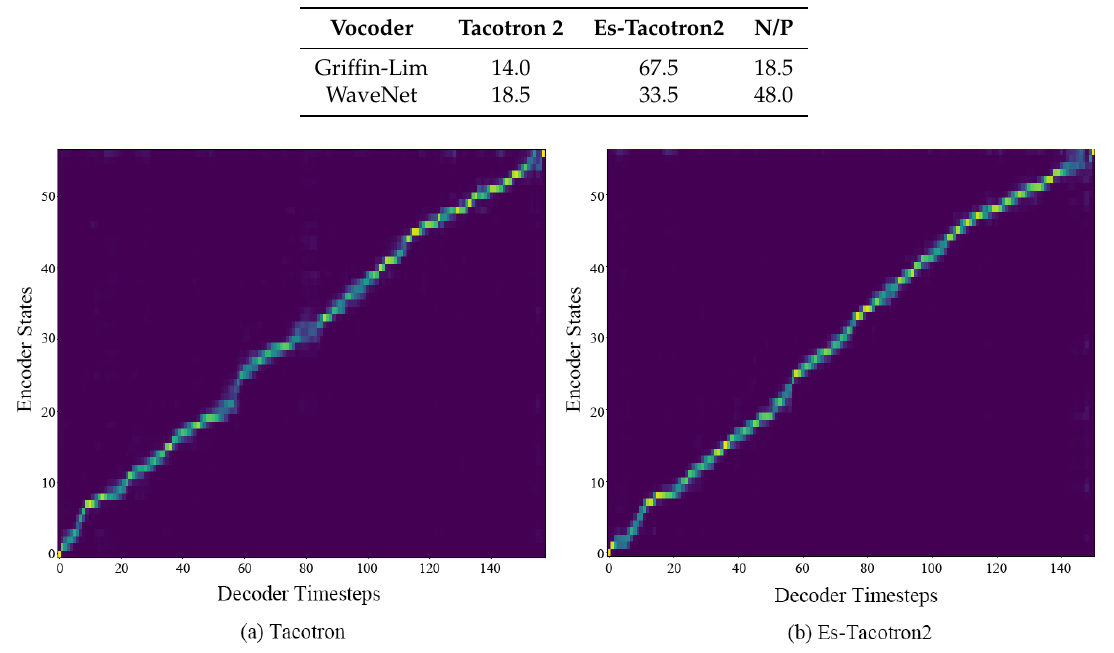
Table 1. Average preference scores (%) on naturalness. “N/P” stands for no preference.